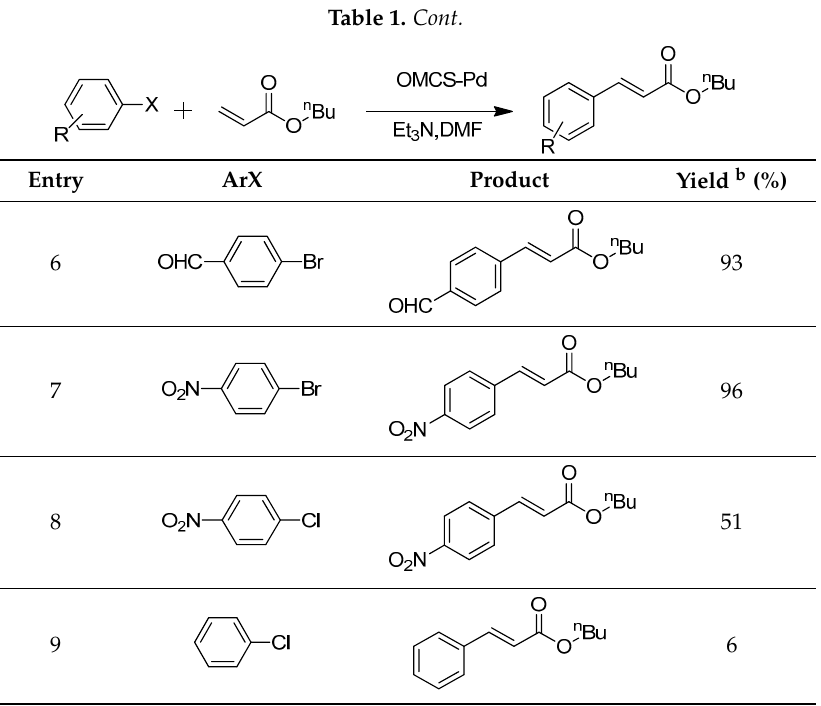
Molecules 2017 , 22 , 150